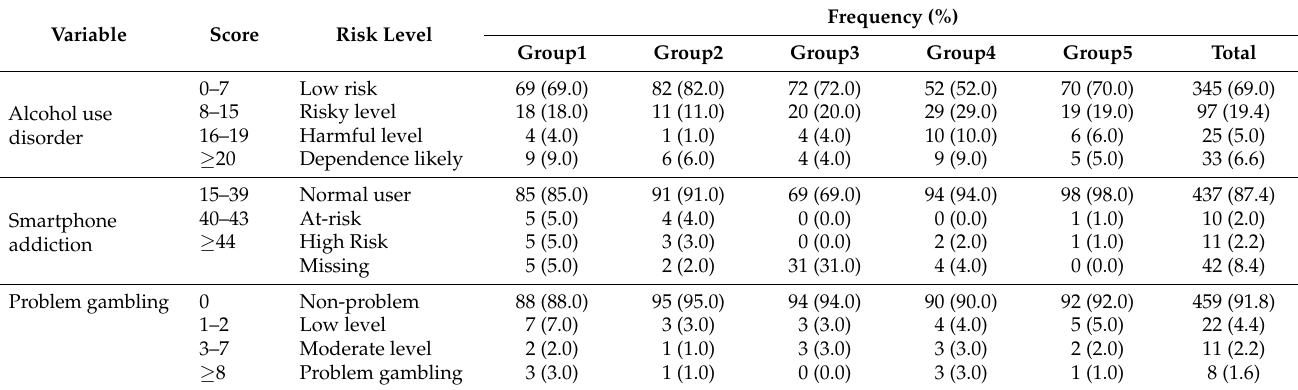
Table 2. Level of addiction problem by